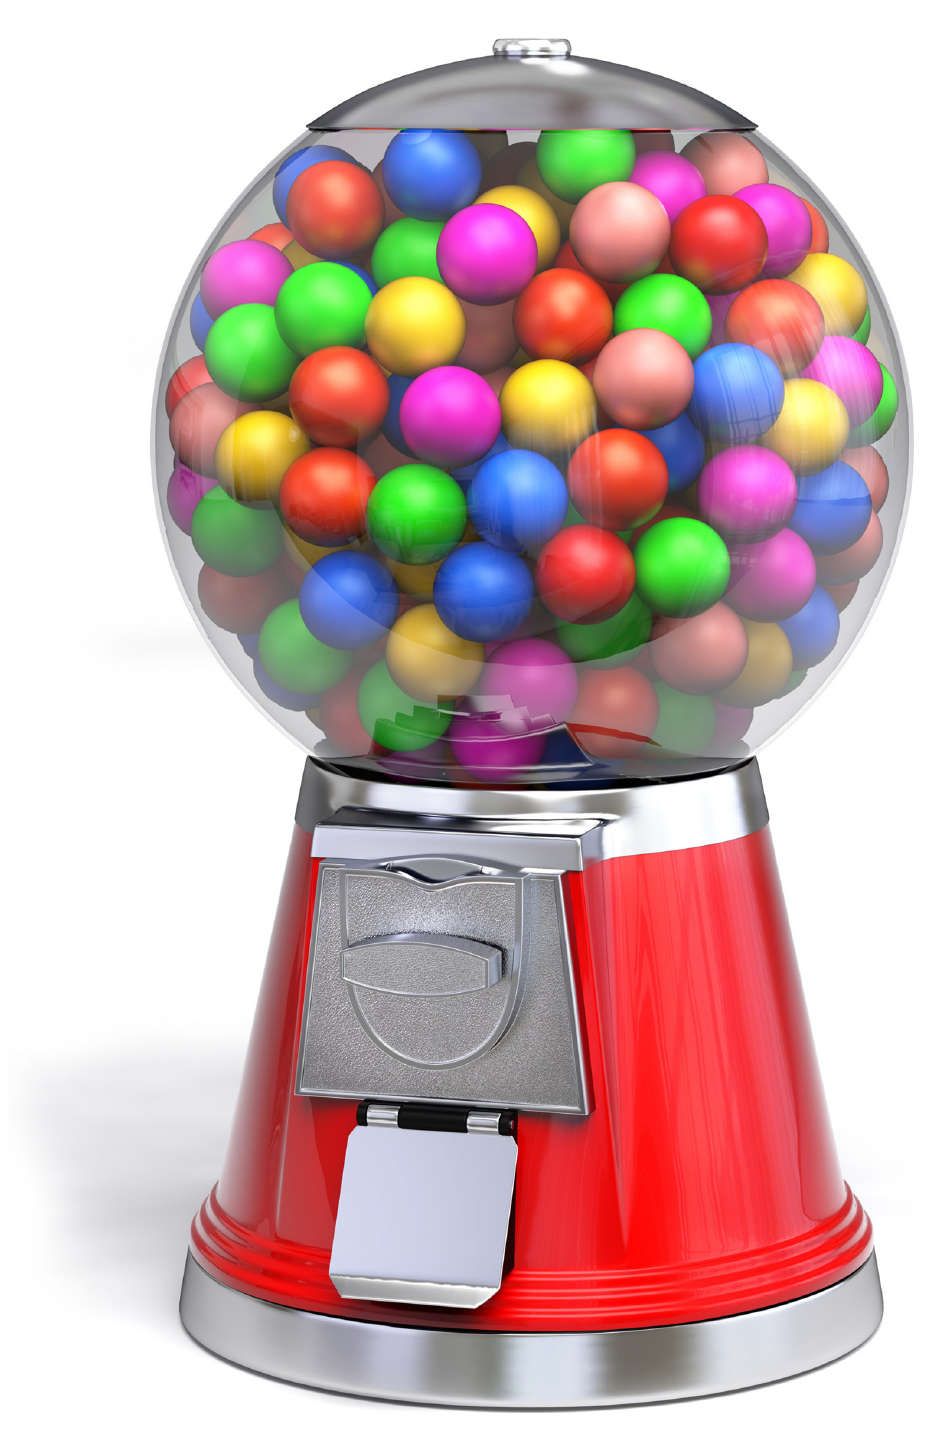
Fig 2. A gumball machine represents sphere packing in a high dimensional space. “Gumball machine” http://www. turbosquid.com/3d-models/3d-model-gum-gumball-machine/648046 by Guido Vrola Design 2016 http://vroladesign. it/ is licensed under CC BY 4.0, reproduced with